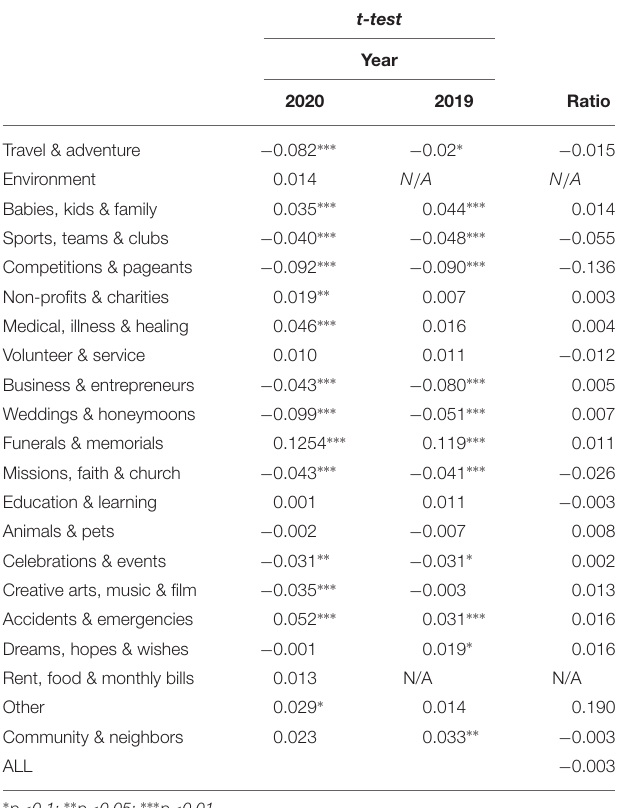
TABLE 2 | Paired sample statistics (N/A indicates not